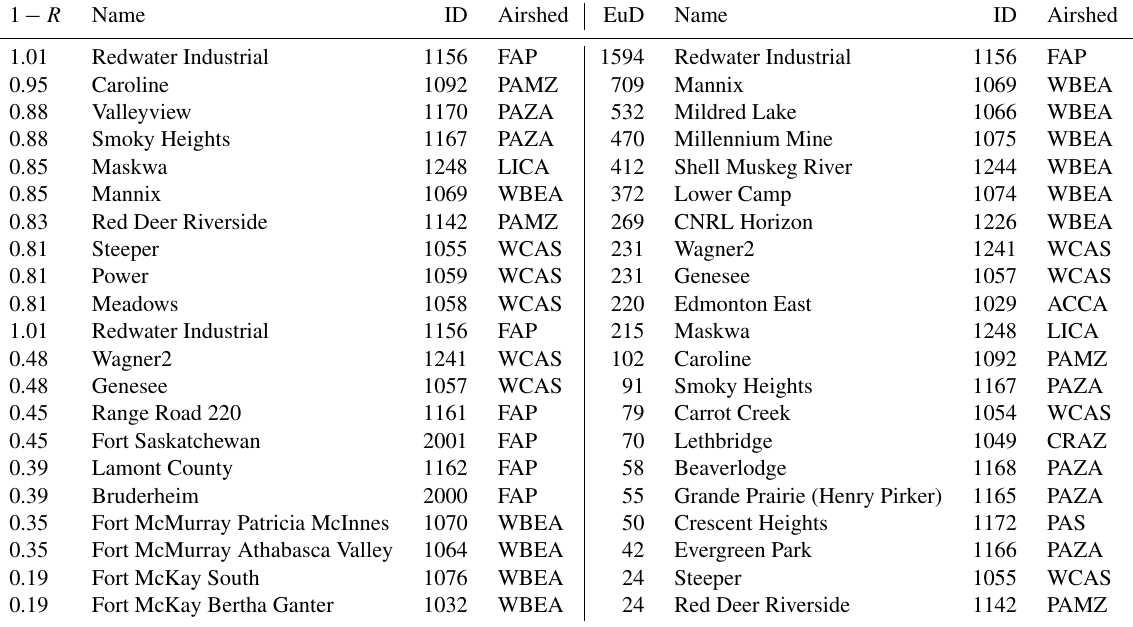
Table 2. Hourly SO 2 similarity ranking. Note that stations at the bottom of the two columns are the most similar (hence one measure of their level of redundancy) with respect to each metric of dissimilarity. Here are only the first and last 10 items of the ranking; the full ranking can be consulted in Table